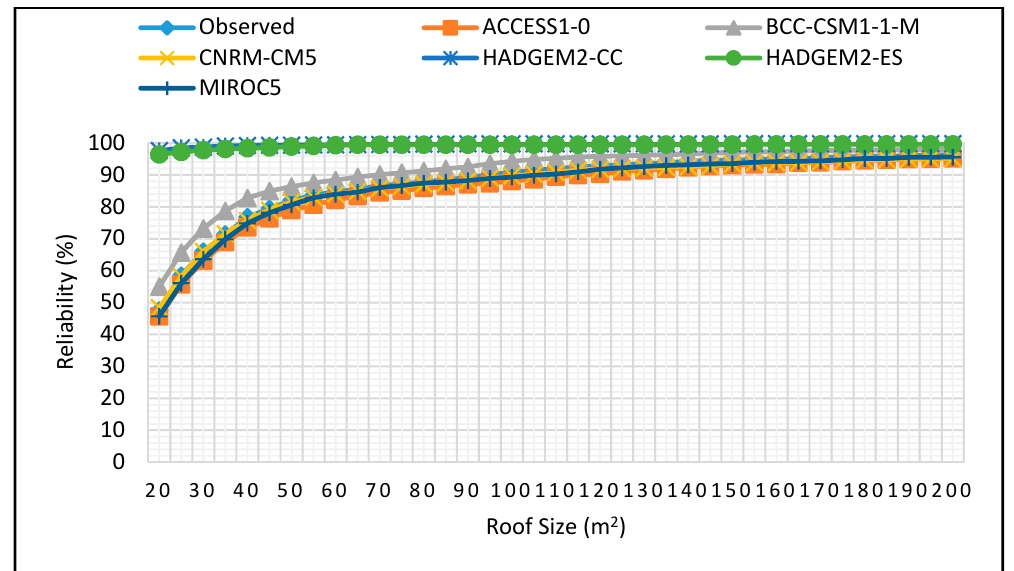
Figure 36. Reliability projections for SON season for 0.5 m 3 tank size for 2060–2090 period.